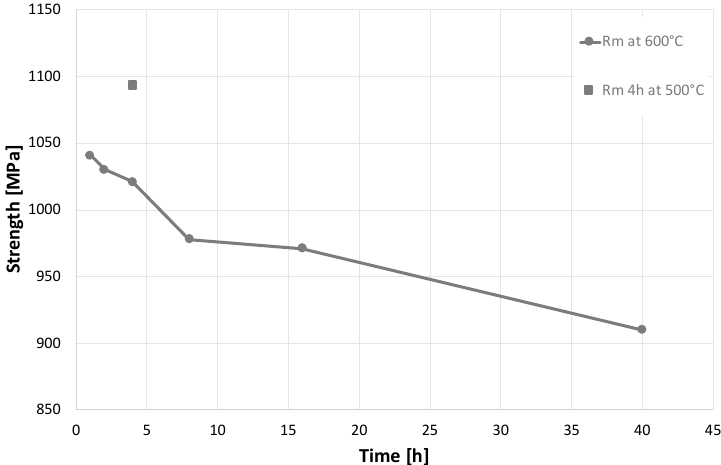
Figure 1. Tensile strength (UTS) as a function of aging time. The connected points are data from aging at 600 °C and the single point marked with a square is the sample aged at 500 °C for 4 h.